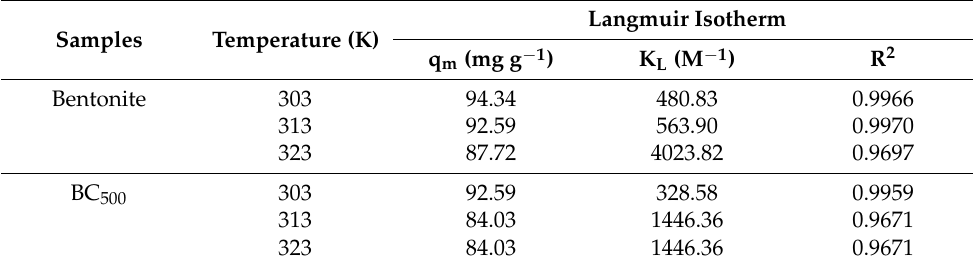
Table 12. Parameters for adsorption of paraquat on bentonite and BC 500